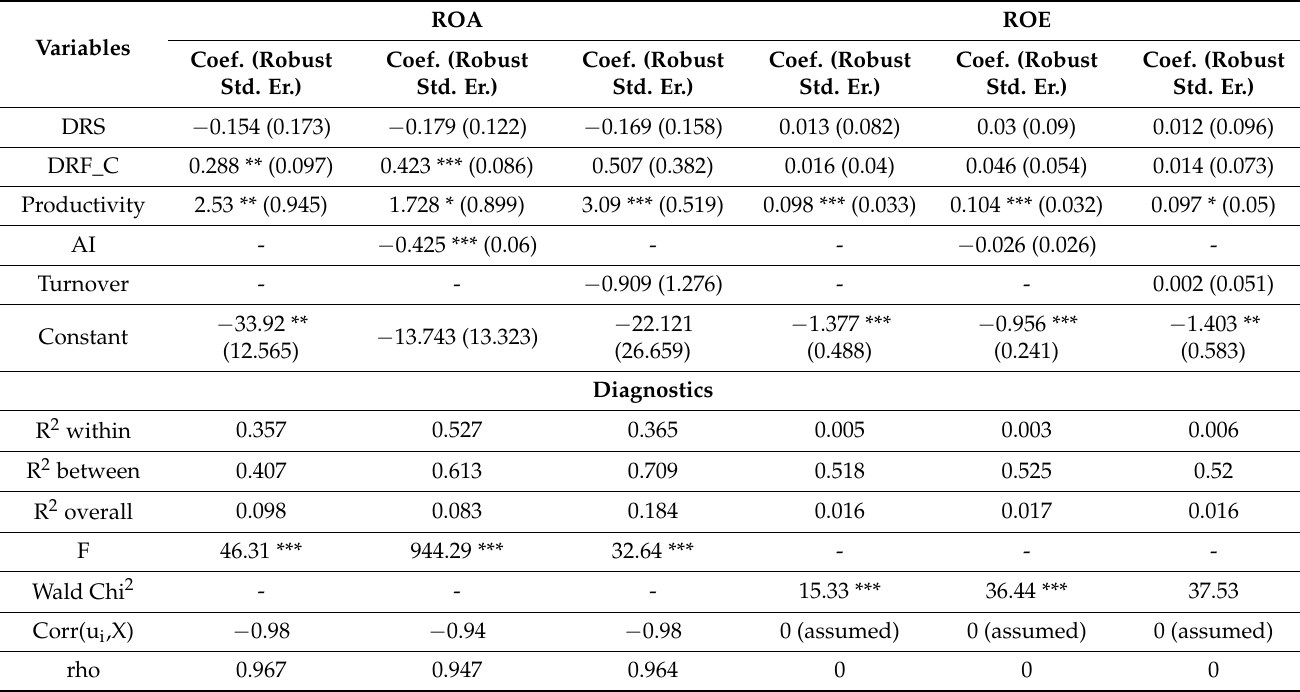
Table 5. Regression results—ROA and ROE as endogenous (robust Equation (1) respecified and with control factors Equation (2) respecified).